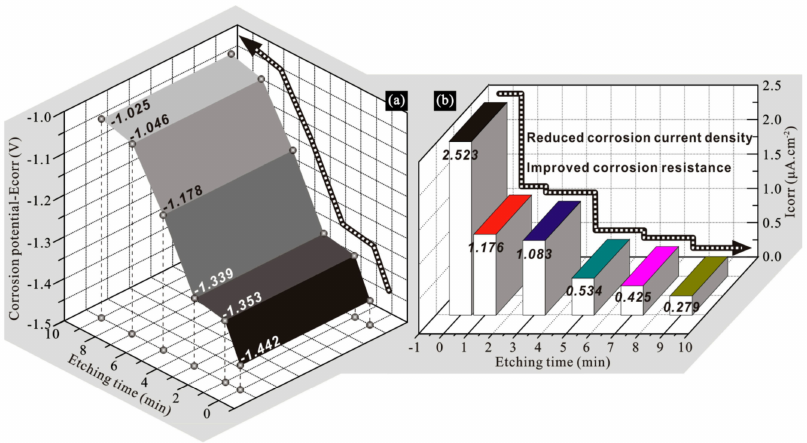
Figure 11. ( a ) Corrosion potentials (E corr ) and ( b ) corrosion current densities (I corr ) of modified 7075 aluminum alloys with various etching times.